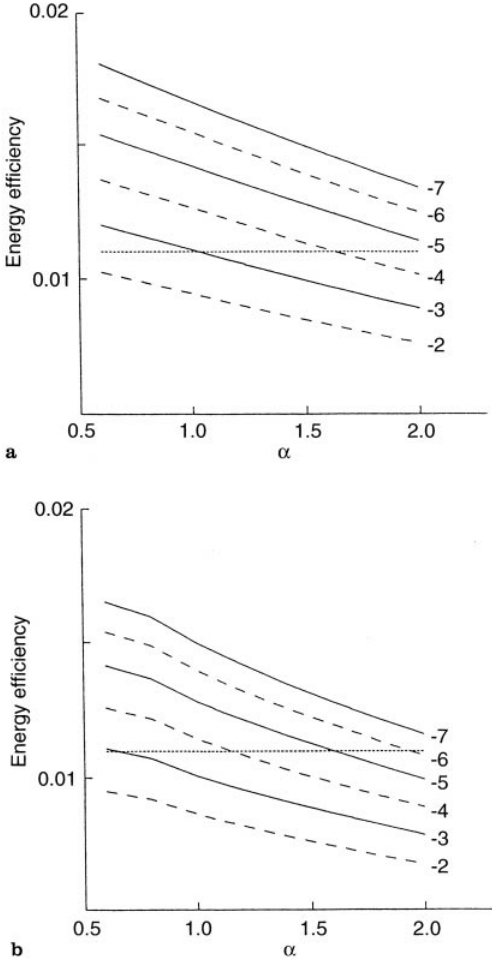
Fig. 4a,b. The comparison of sum of calculated energy e(cid:129)ciencies of mechanisms (1) and (2a, 2b) for (cid:107) 1 (cid:136) ) 7– ) 2 ( solid and dashed lines ) with experimental estimation of Rawlins et al . (1981) ( dotted line ): a n (cid:136) 1, b n (cid:136)